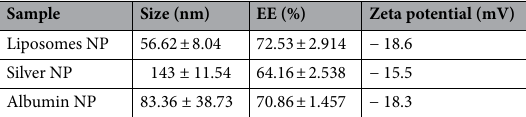
Table 1. Characterization of NPs from F. cretica plant